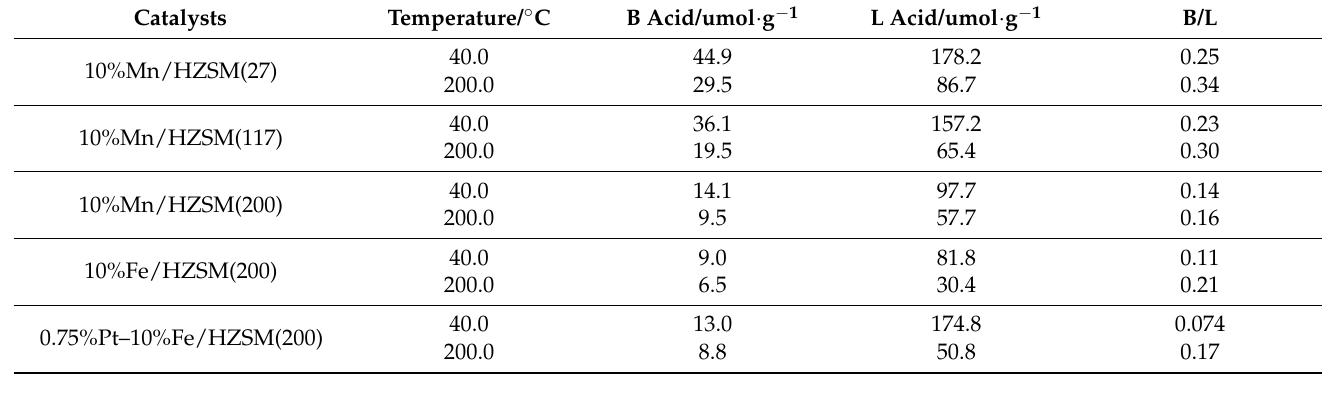
Table 6. Quantitative analysis of Brönsted and Lewis acids from the Py-IR spectra.